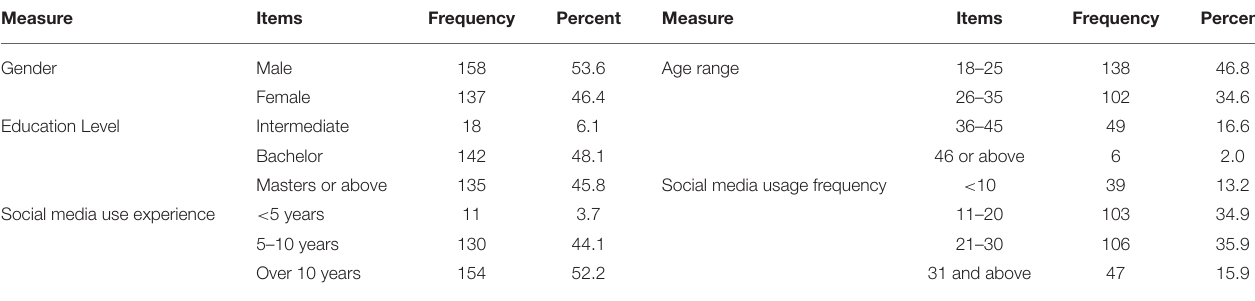
TABLE 1 | Demographic information of